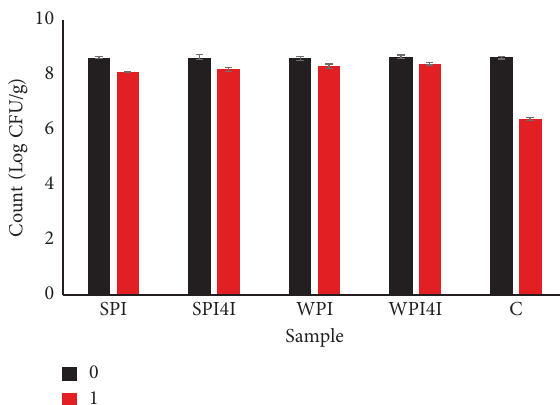
Figure 5: Effect of bile salt (0 and 1%) on the viability of L. reuteri encapsulated within different wall materials; SPI (soy protein isolate 20%), SPI4I (soy protein isolate 20% +inulin 4%), WPI (whey protein isolate 20%), WPI4I (whey protein isolate 20% +inulin 4%), and C (free bacteria).